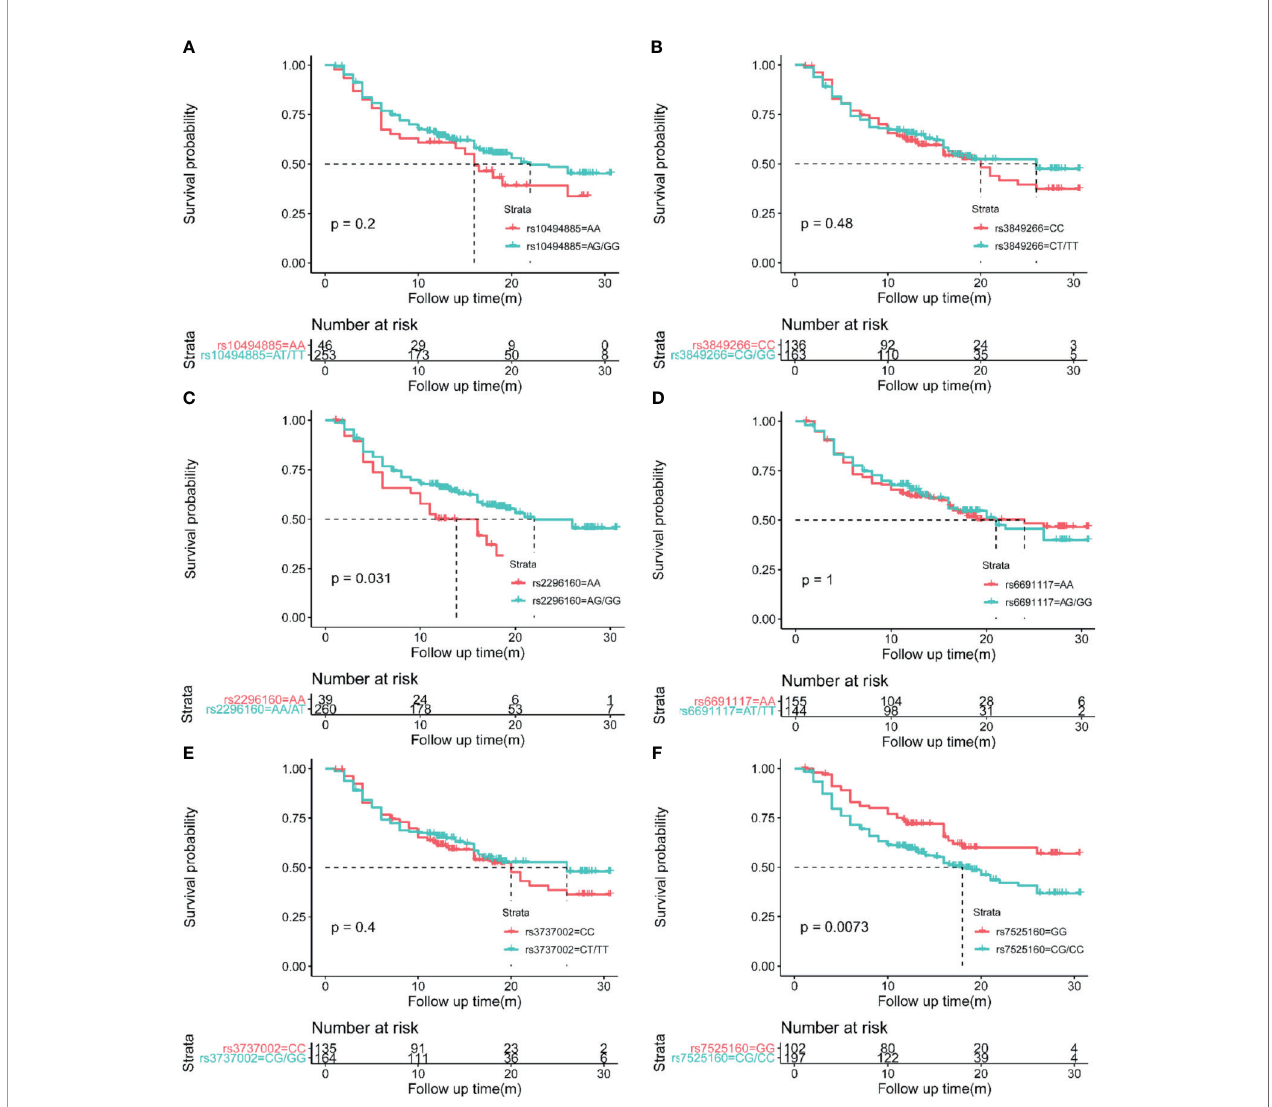
FIGURE 1 | Kaplan-Meier analyses of CD35 genetic variation on postoperative HCC recurrence. (A) CD35 rs10494885. (B) CD35 rs3849266. (C) CD35 rs2296160. (D) CD35 rs6691117. (E) CD35 rs3737002. (F) CD35